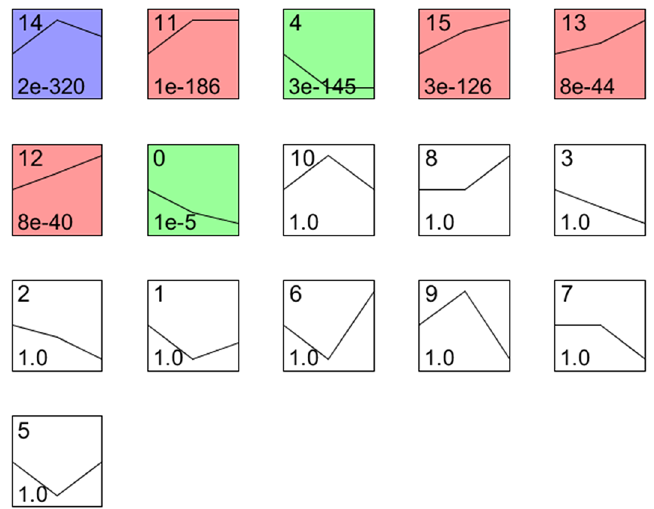
Figure 3. Profiles clustered during floral development in tree peony. The upper number represents profile name. The lower number represents p -value. The line represents the gene expression pattern of each profile. The colors in the boxes mean statistically significant with a p -value less than